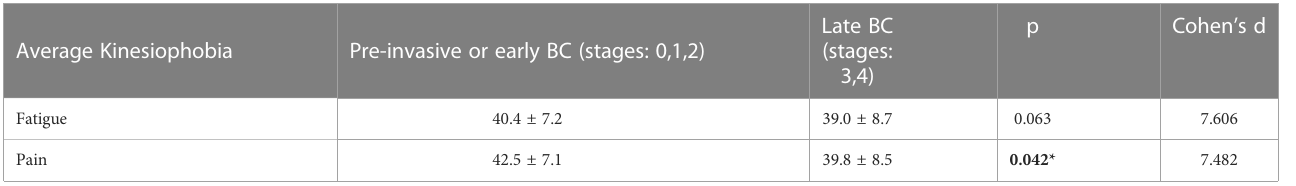
TABLE 5 Level of kinesiophobia and cancer stage.